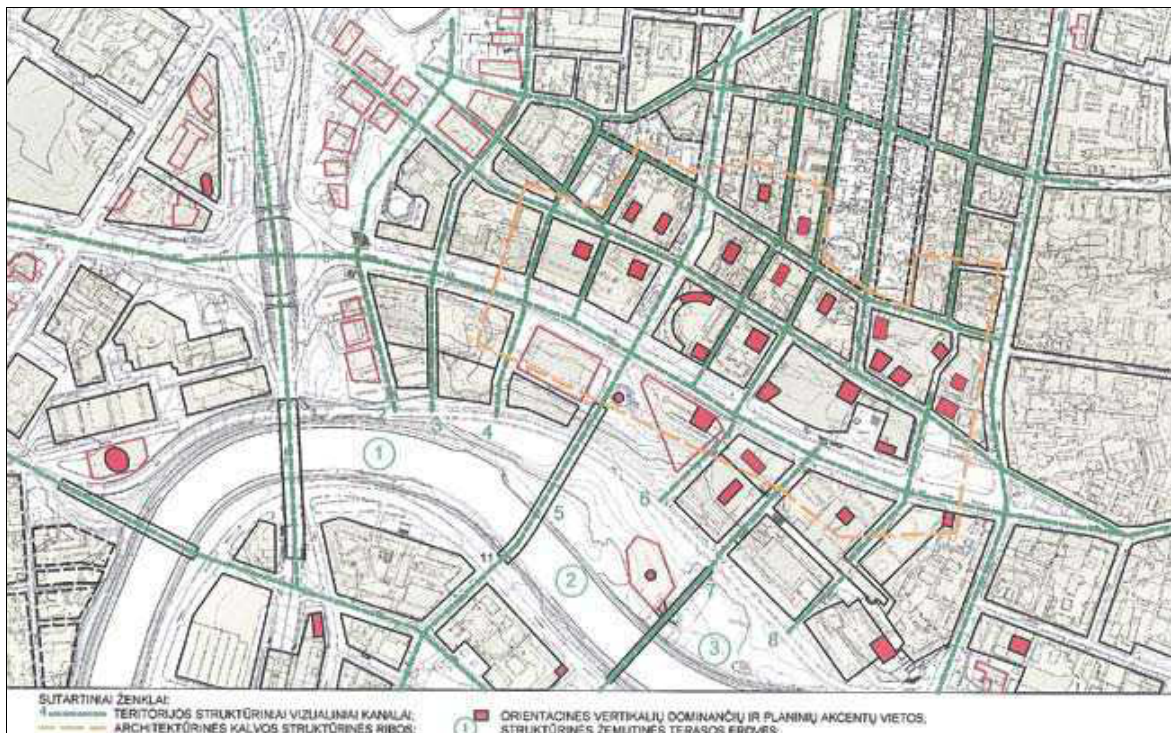
Fig 8. Planned structure of built-up